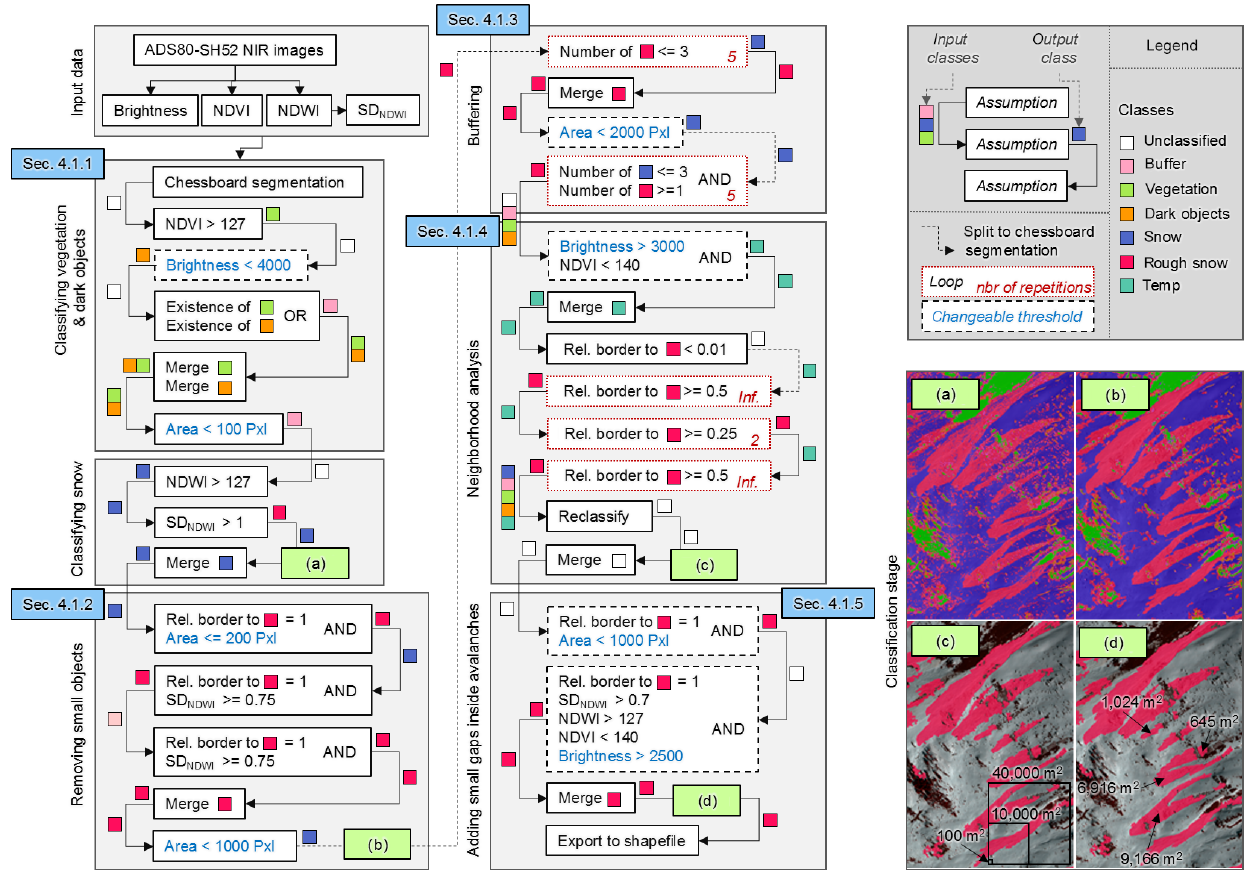
Figure 4. Workflow for classifying snow avalanches with object-based image analysis (OBIA). The white boxes indicate the classification; dashed outlines feature the number of reiterations (red), and the local decision boundaries show change (blue). The colours of squares are coded to the input and output class in each step. Panels (a–d) represent visual results of the sub-step classification. The squares and numbers on (c) and (d) represent a sample segment size. Section 4.1.1–4.1.5 in the figure are the numbers of subchapters in the